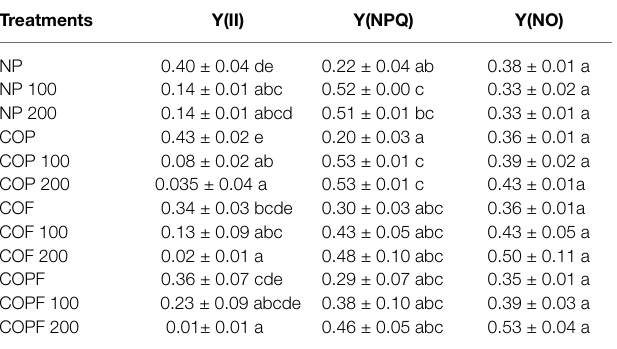
TABLE 1 | Effect of salinity and coumarin applications on chlorophyll fluorescence in Sorghum bicolor plants.